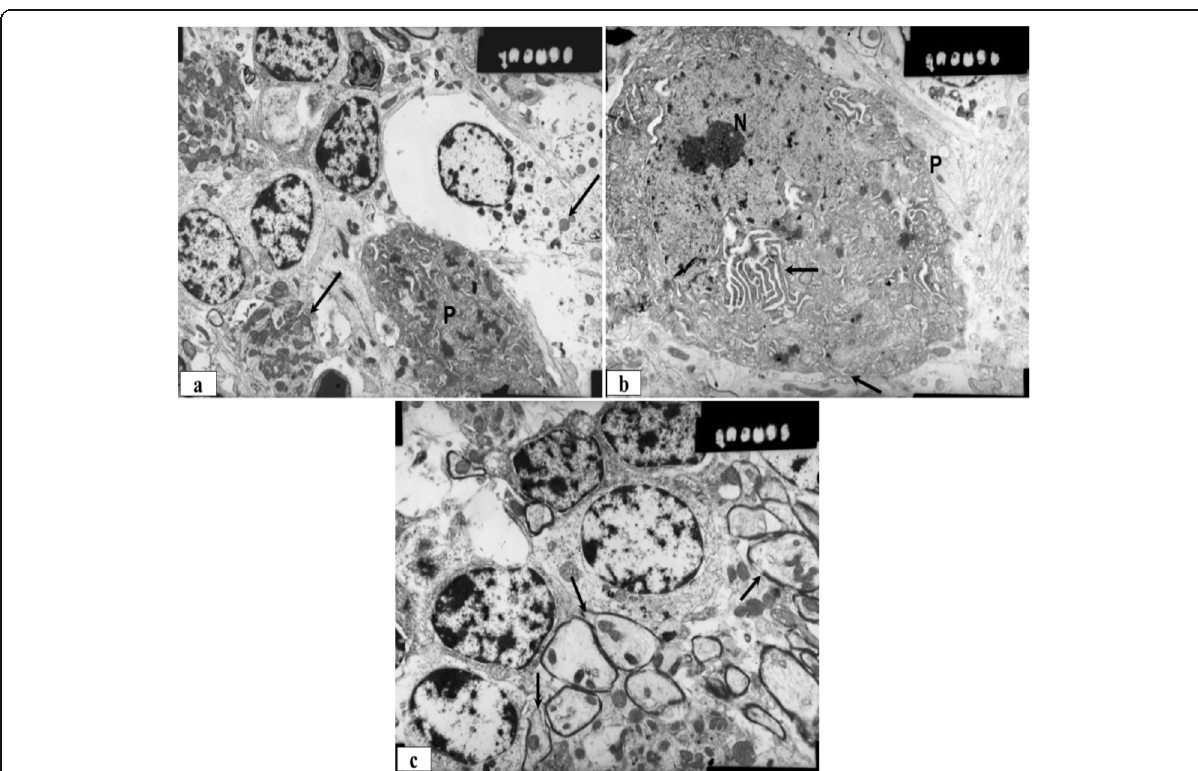
Fig. 5 a – c Electron micrographs of a section of the cerebellar cortex of mice treated with 10mg/kg bw cisplatin showing a shrunken Purkinje cell (P) with pyknotic nucleus (N). Notice the dilatation in rER and focal areas of splitting myelin sheath of the nerve in c (arrows). × 5000 (bar = 10 μ